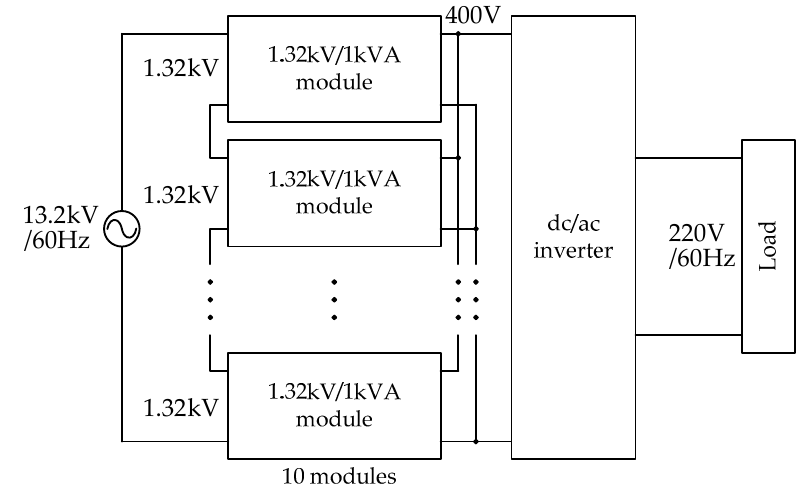
Figure 2. Power stage configuration of the 13.2 kV/10 kVA SST.